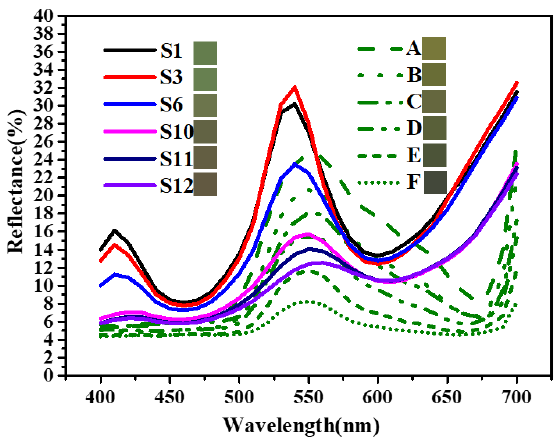
Figure 9. Diffuse reflectance spectra (400–700 nm) of Cr 2 O 3 samples (S1 to S12) and Ficus microcarpa leaves (A–F).